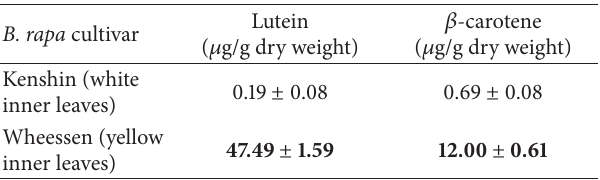
Table 1: Content of lutein and 𝛽 -carotene in two contrasting Chinese cabbage